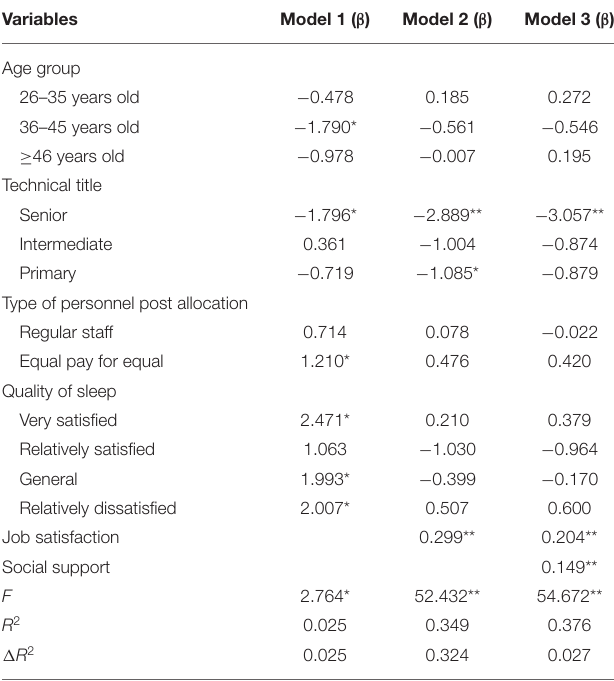
TABLE 4 | Hierarchical linear regression for exploring the correlates of job